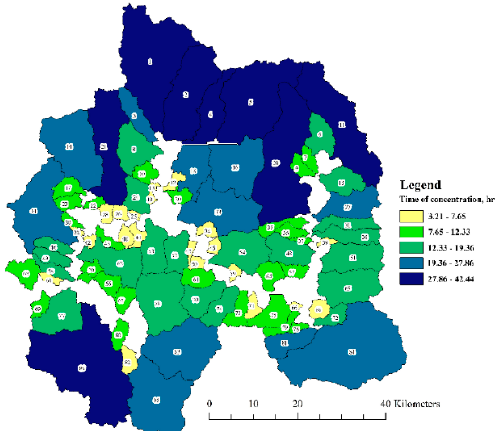
Figure 10. Time of concentration of sub-watershed in the study.